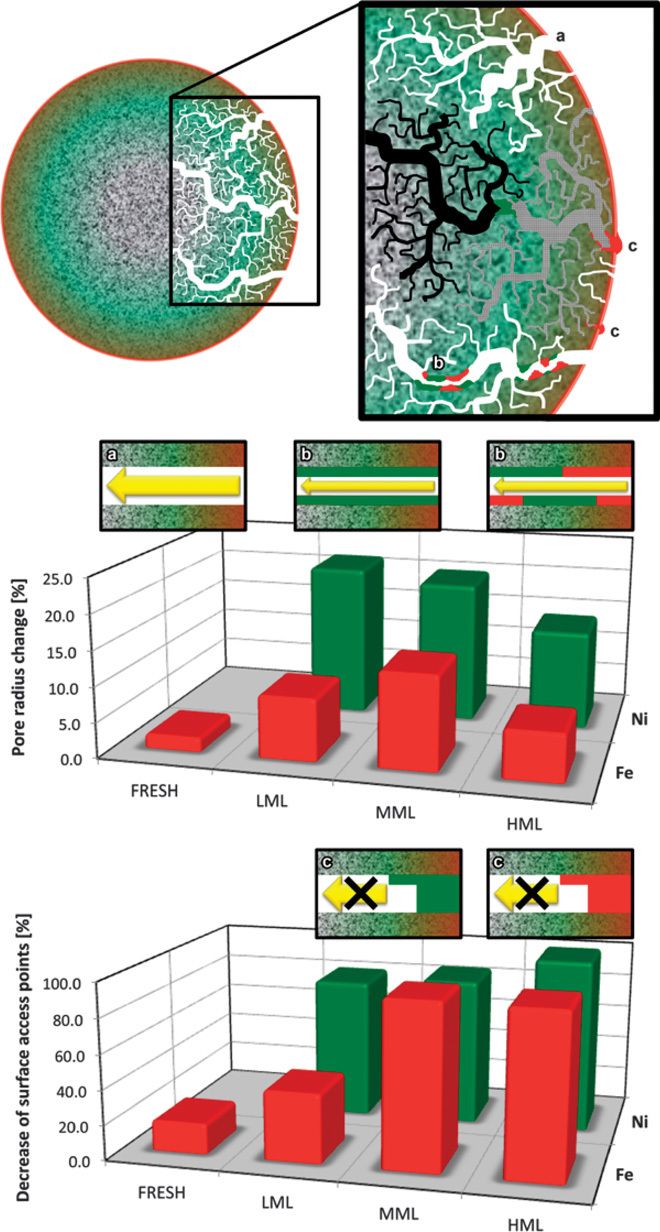
Changes in the pore accessibility of a single FCC catalyst particle as a function of metal content and type.(Top) Scheme for metal deposition in the pore network, indicating Fe (red) mainly at the outer surface and Ni (green) penetrating more deeply, as demonstrated in Fig. 3. Pore channels can remain open (a), become narrowed (b), or have blocked accessibility (c) by metal deposition in surface pore access sites. Case “c” may also be that macropores (>64 nm) have been converted to mesopores (<64 nm) that are no longer visible with this method. (Middle) Pore radius change in percent as a function of particle age for Fe (red) and Ni (green), respectively. For the FRESH sample, the pore radius change is negligible, indicating that the pore network is not affected by macropore narrowing (that is, case “a” represented by the corresponding inset). The two other insets schematically display how pore narrowing becomes significant for the LML and MML samples and is dominated by Ni in the early phase (LML sample). (Bottom) Decrease of surface access points in percent as a function of particle age for Fe (red) and Ni (green), respectively. The two insets schematically depict how at an earlier stage (LML) Ni dominates the reduction of surface macropores that provide access to the internal pore network of the particle (case c), while later (MML and HML), both metals cause severe access restriction through macroporosity.